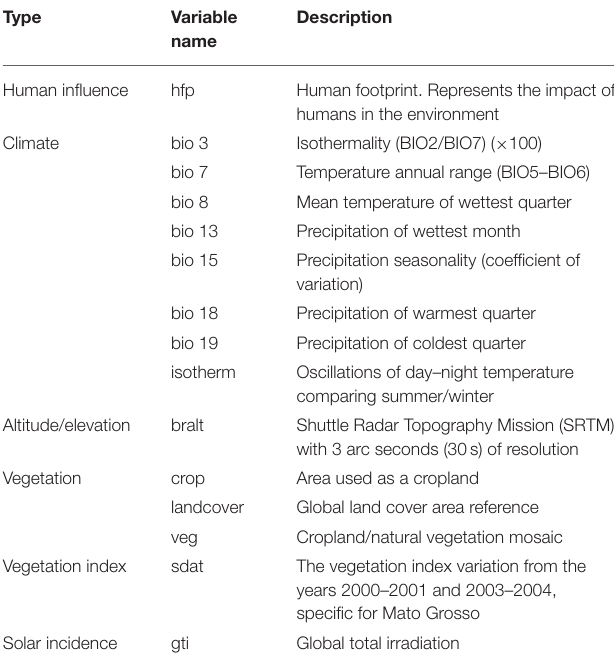
TABLE 2 | Environmental variables used to predict the distribution of wild boars in the state of MT, using a maximum entropy (MaxEnt)